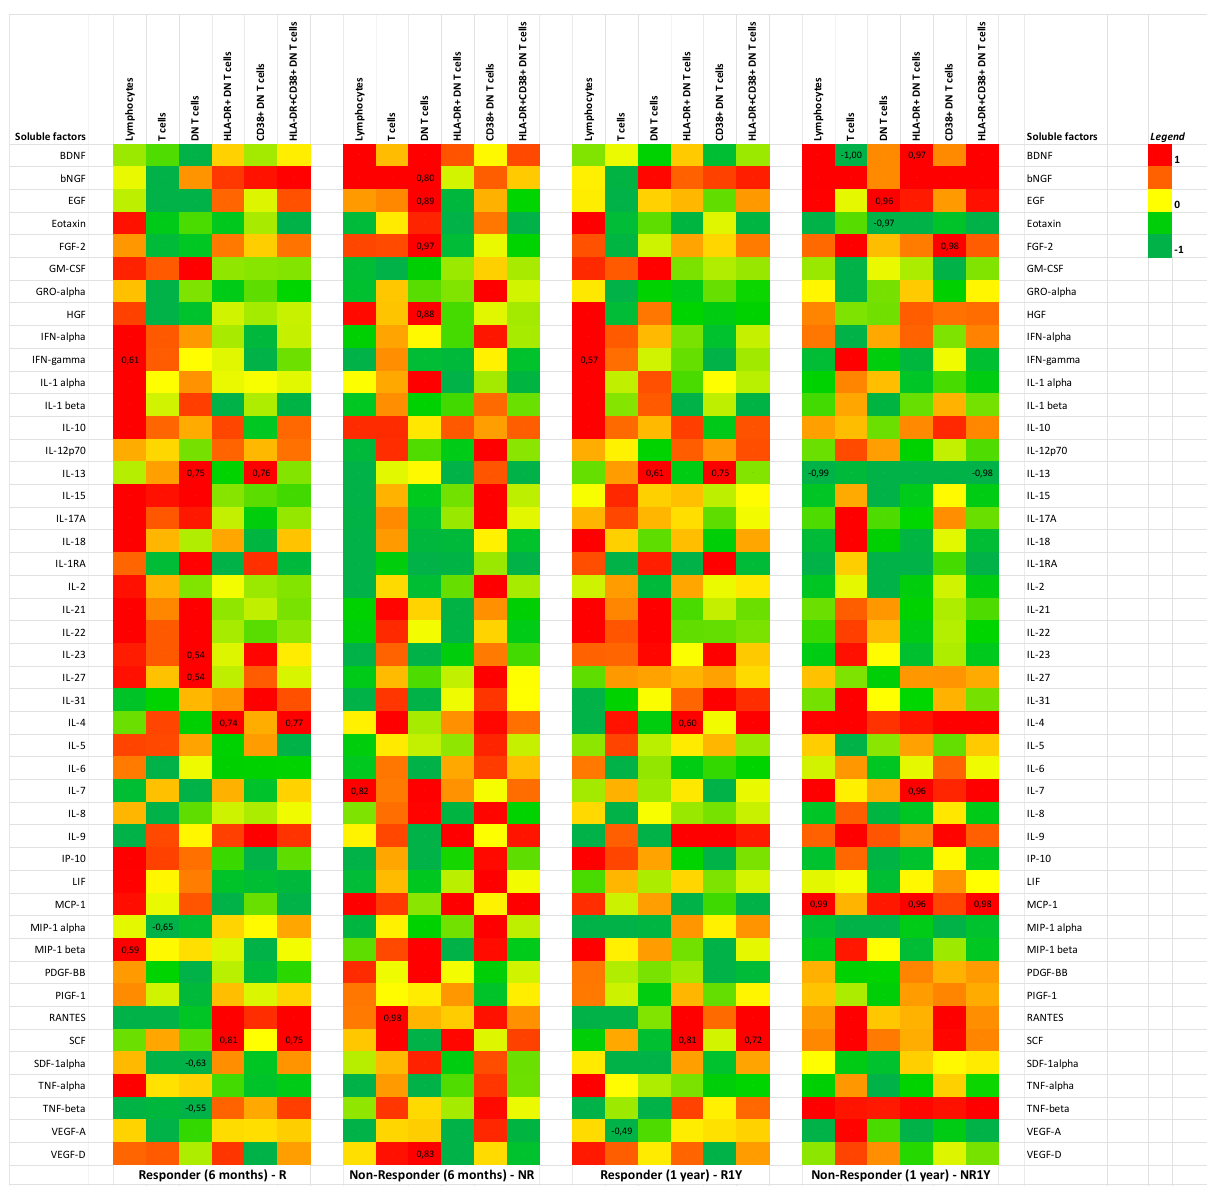
Figure 4. Correlation between soluble factors and DN T cells in responders. Panels present heatmaps of soluble factors according to response (R/NR — 6 months; R1Y/NR1Y — one year. Pearson’s correlation was used to explore the association of soluble factors and cell populations indicated at the top of each block. Pearson’s values are indicated in squares and correspond to significant p values (<0.05). LIF—leukemia inhibitor factor; R1Y—responders at one year; NR1Y—non-responders at one year.